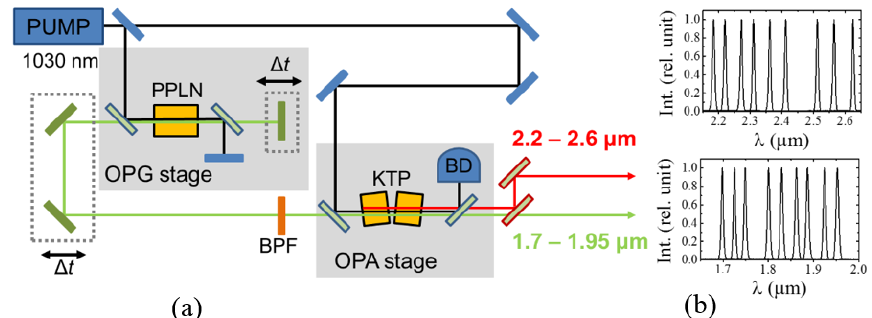
Figure 4. Tunable picosecond optical parametric generator (OPG) followed by optical parametric amplifier stage (OPA): ( a ) Optical scheme of the frequency conversion system (PPLN—periodically